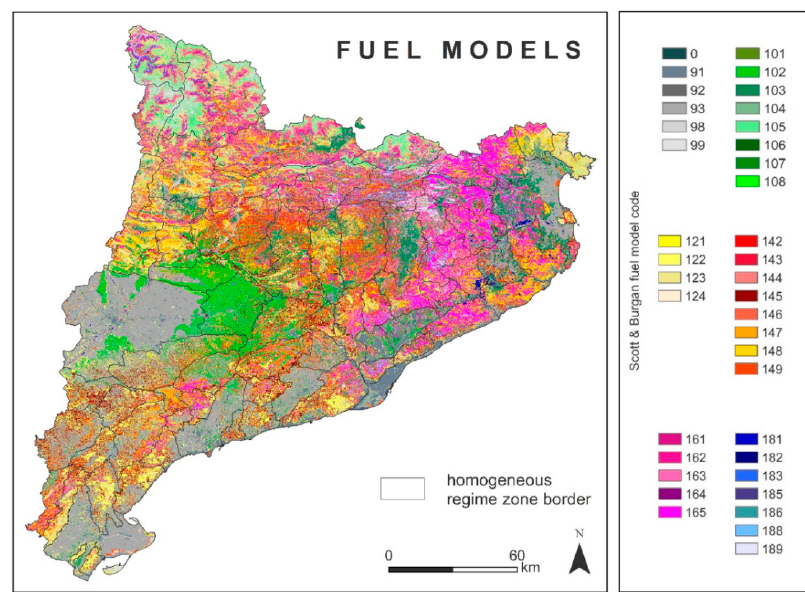
Figure 5. Fuel models map of Catalonia, according to Scott and Burgan [62]. Remote Sens. 2018 , 10 , x